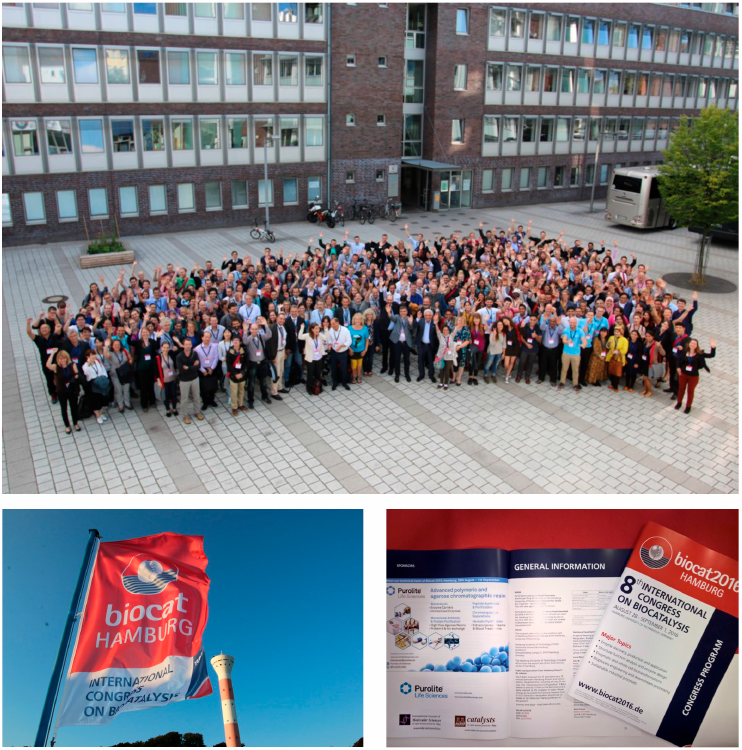
Figure 1 . Impressions from the conference biocat2016. Top: Group picture. Bottom left: Biocat flag on board of a paddle wheel steamer on the Elbe River. Bottom right: Conference program ( 8th International Congress of Biocatalysis : Biocat2016 , Book of Abstracts ; Antranikian, G., Ed.; Tutech Innovation